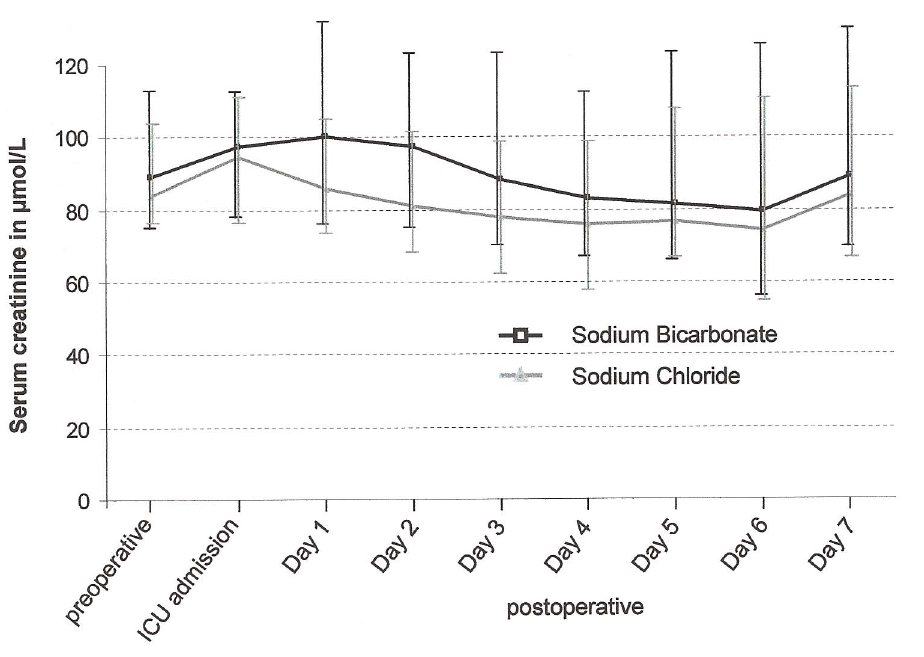
Figure 3. Serum creatinine in patients receiving sodium bicarbonate (black squares) or sodium chloride (grey triangles) infusion. Serum creatinine concentrations are shown over time (median [25th–75th percentiles]).